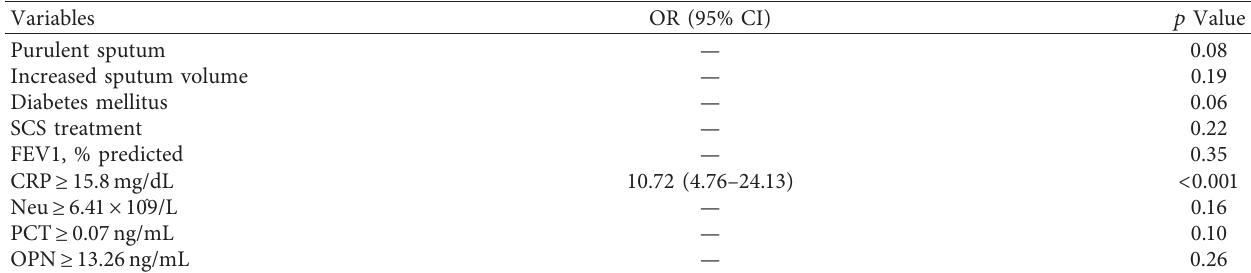
Table 5: Logistic regression model of factors predicting CAP in